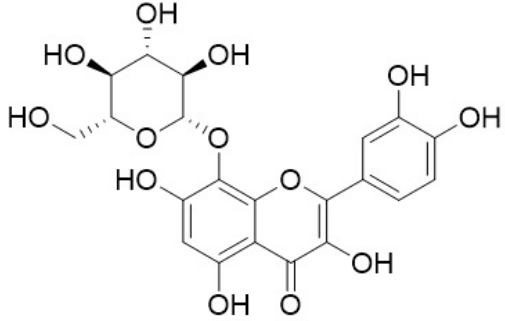
Figure 4. Chemical structure of